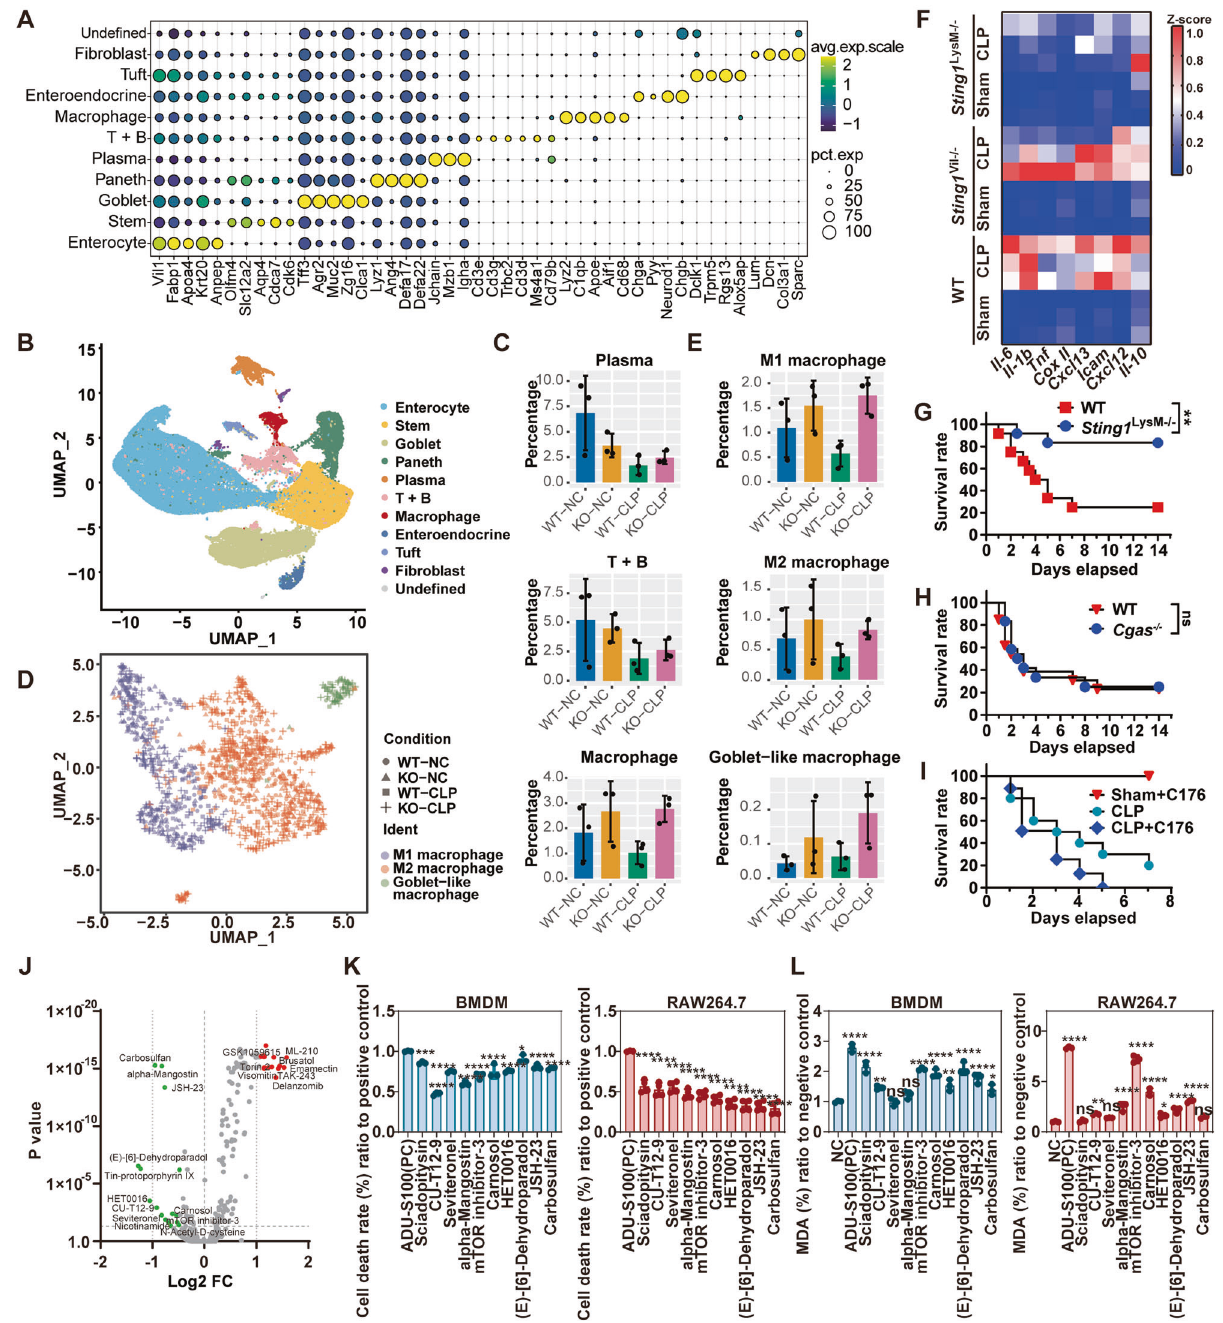
Fig. 1 STING is responsible for macrophage lipid peroxidation and cell death. A Expression of indicated cell-type-speci fi c genes is plotted across all cell types from the intestine of WT or Sting1 − / − mice subjected with or without CLP model ( n = 3 per group). avg.exp.scale scaled average expression of the gene, pct.exp percentage of cells that express the gene. B UMAP plots displaying 62,307 single cells from the intestine of WT or Sting1 − / − mice subjected with or without CLP model divided into 11 subtypes, based on the expression of known marker genes ( n = 3 per group). C Bar plots compare the percentages of plasma cells, T and B cells, and macrophages in WT or Sting1 − / − mice subjected with or without CLP model. D Unsupervised clustering of macrophages ( n = 1341 cells total) identi fi ed three subclusters of macrophages. E Bar plots compare the percentages of M1, M2, and goblet-like macrophages in WT or Sting1 − / − mice subjected with or without CLP model. F Heatmap of in fl ammatory cytokine mRNA changes in intestinal tissue of indicated mice with or without sepsis model for 24 h ( n = 3 per group). G – I Survival analysis of indicated mice is shown ( n = 13 per group). Mice were repeated intraperitoneal administration of C-176 (13.42 mg/kg) at 2 h before CLP and 12, 24, 48, and 72 h after CLP. J Volcano plot of cytotoxicity fold change after treating with compounds library in ADU-S100 (29 μ M) stimulated RAW264.7 cells for 24 h ( n = 3 per group). K , L Cell death rate ( K ) and production of MDA L assayed from BMDMs or RAW264.7 cells treated with ADU-S100 (29 μ M) in the absence or presence of indicated bioactive compounds (5 μ M) for 24 h ( n = 3 per group). Data are shown as mean ± SD, and analysis by one-way ANOVA test. CLP cecal ligation and puncture, MDA malondialdehyde, BMDMs bone marrow-derived macrophages. * P < 0.05, ** P < 0.005, *** P < 0.0005, **** P < 0.0001.